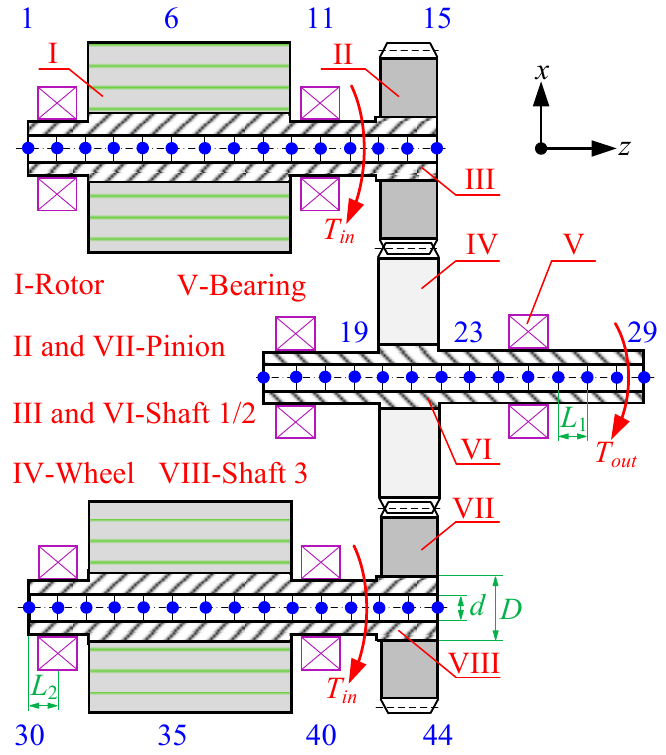
Figure 2. Dynamic model and node distribution diagram of DMDS.